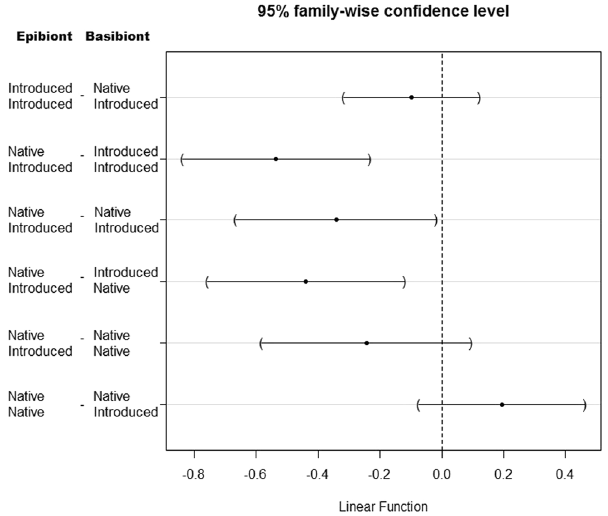
Figure 3. Plot of Tukey contrasts following a generalised mixed effects model comparing bryozoan larval settlement on space adjacent to test encrusting basibiont species.